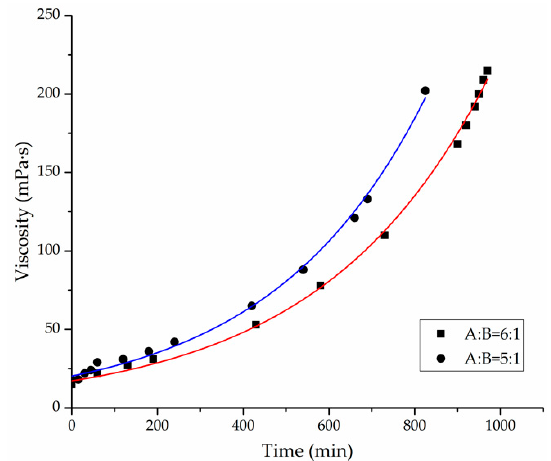
Figure 1. The change curve of viscosity of the slurry.